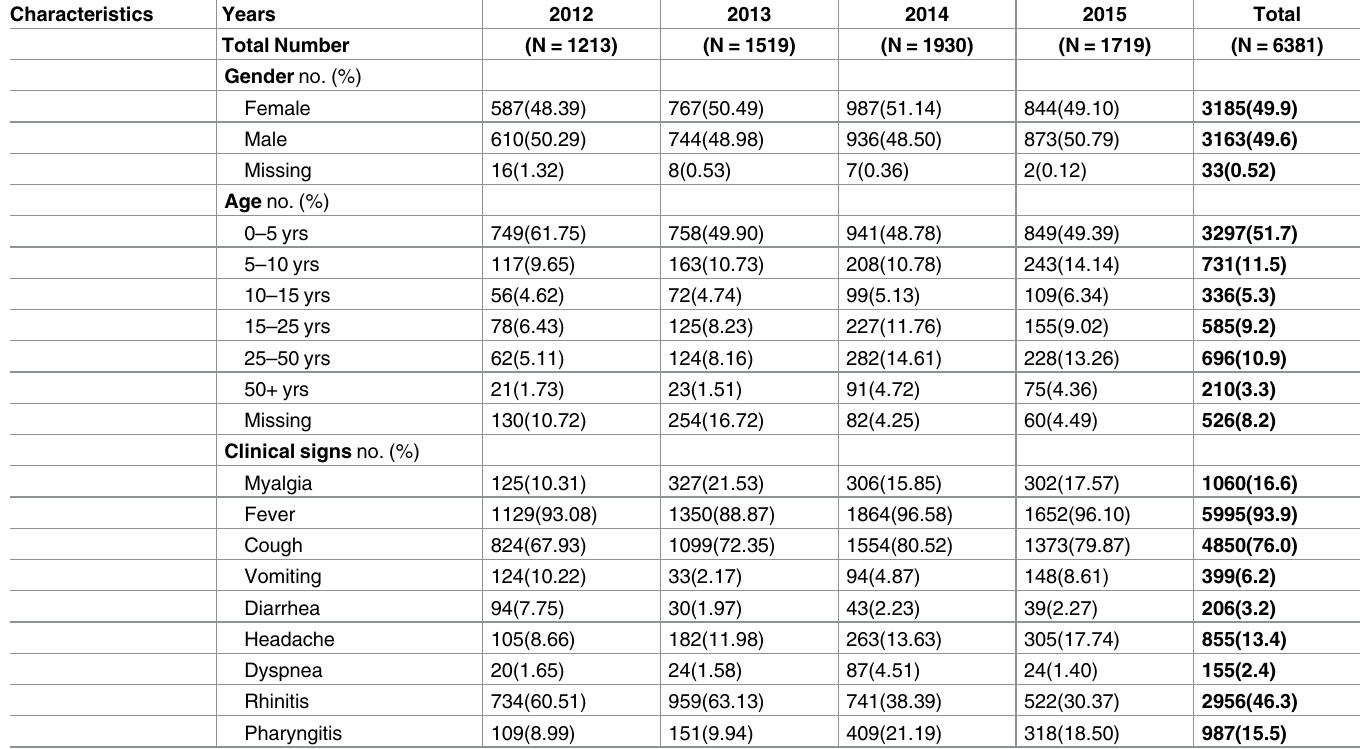
Table 1. Demographical characteristics of patients and most prevalent symptoms. Characteristics